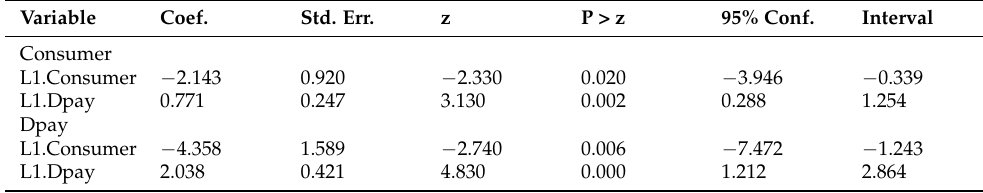
Table 8. Analysis results of PVAR model.